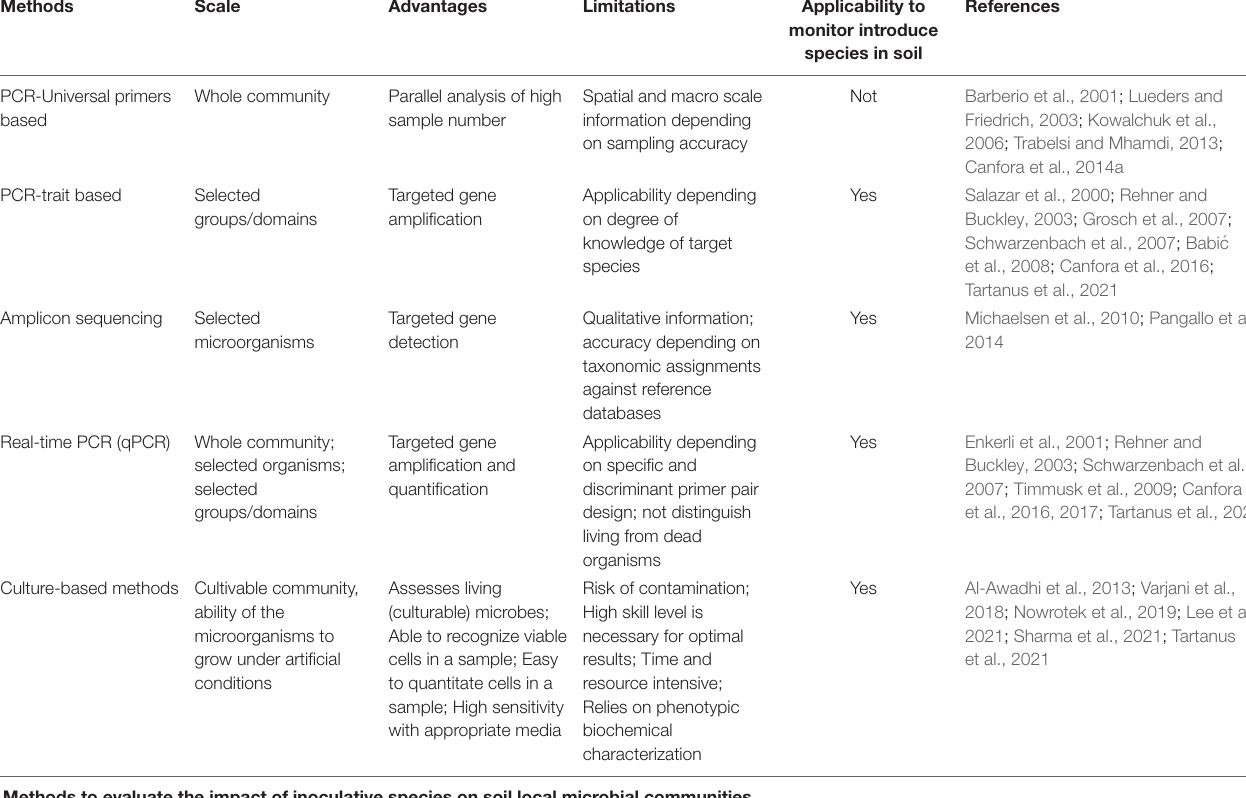
TABLE 2 | List of PCR-based and culture-dependent methods: advantages and